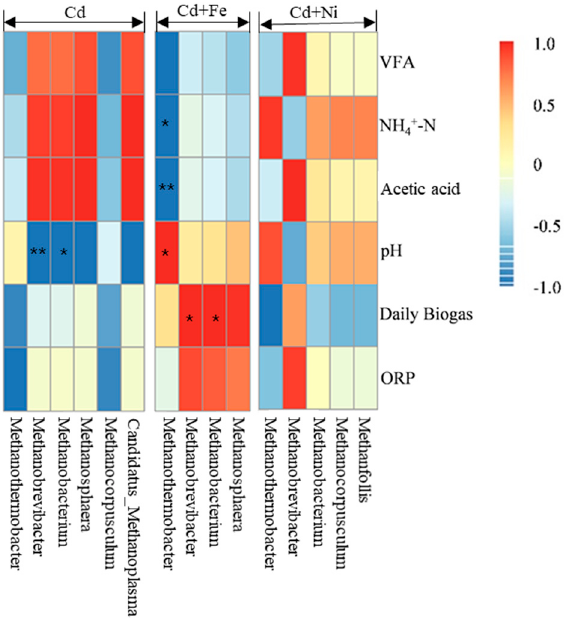
Figure 8. Pearson correlation analysis between environmental factors and methanogen under Cd, Cd + Fe, and Cd + Ni addition during the fermentation.